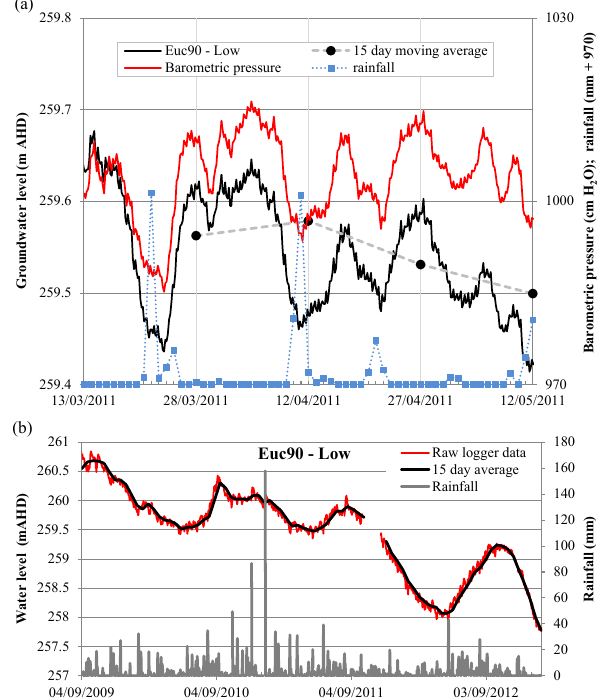
Figure 3. (a) Barometric pressure (in equivalent cm of H 2 O), groundwater logger data, rainfall and the 15 day moving average used for the water table fluctuation method estimates of groundwa- ter recharge. The black dots represent the average groundwater level for the preceding 15 days. (b) Full record for the bore used in (a) – Euc90 – showing the complete removal of the large amount of barometric noise, but keeping the overall trend of the 15 day